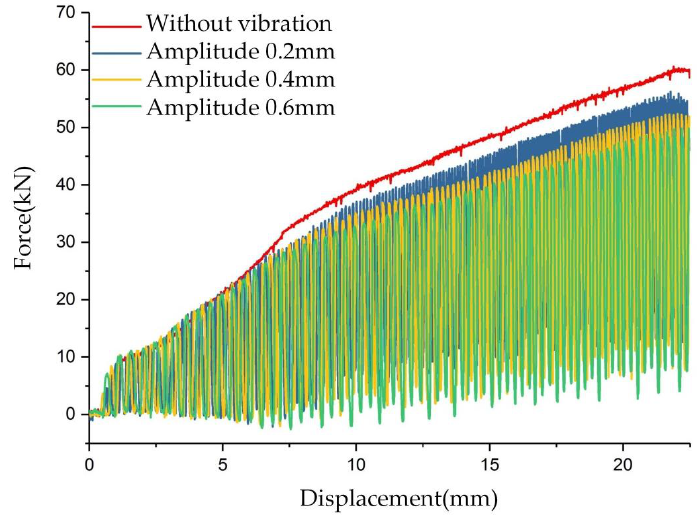
Figure 8. Comparison of load–displacement curves of clutch hub forming with different vibration amplitudes.